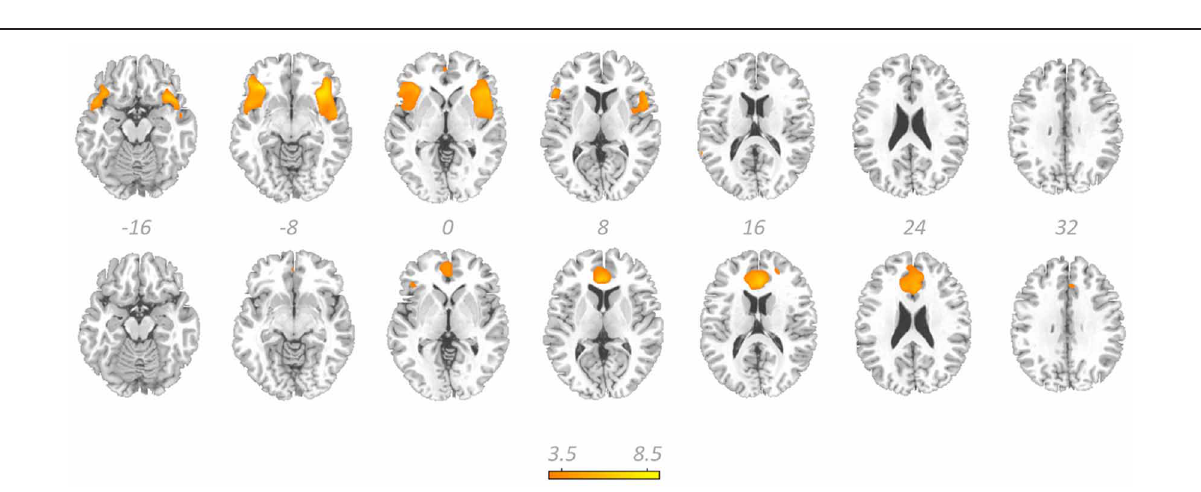
FIGURE 5 | The salience network. Showing the best-fit frontoinsular cortex component (top row) and the best-fit anterior cingulate cortex component (bottom row) overlaid on a standardized T 1 -weighted image.